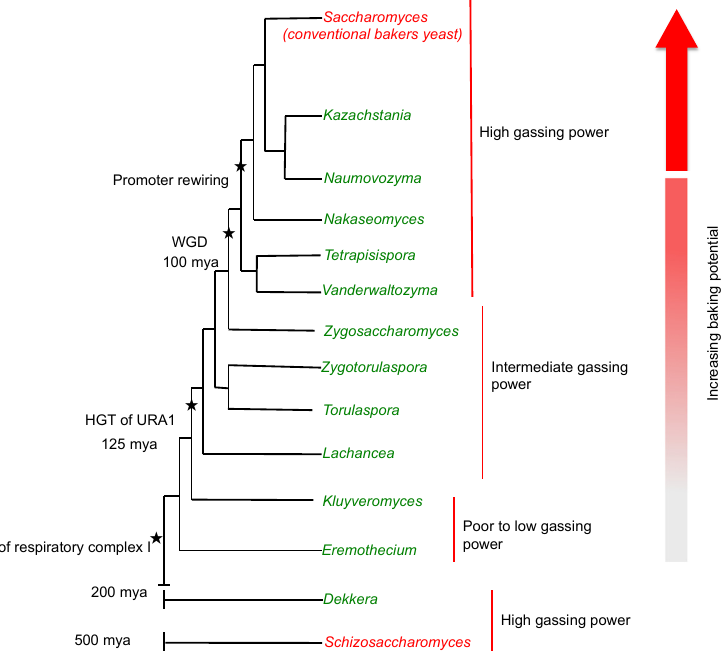
Figure 2. Alternative yeasts and molecular events behind their respirofermentative lifestyle. The figure is redrawn from [6]. Promoter rewiring and loss of rapid growth elements [59], WGD [60], the horizontal gene transfer of URA1 [61] and the loss of respiratory complex I [62] as molecular mechanisms responsible for fermentative metabolism are shown. Specific phylogenetic positioning and ability to ferment under aerobic conditions (Crabtree positivity) reflects the work by [32]. Green colour shows non-conventional/alternative baker’s